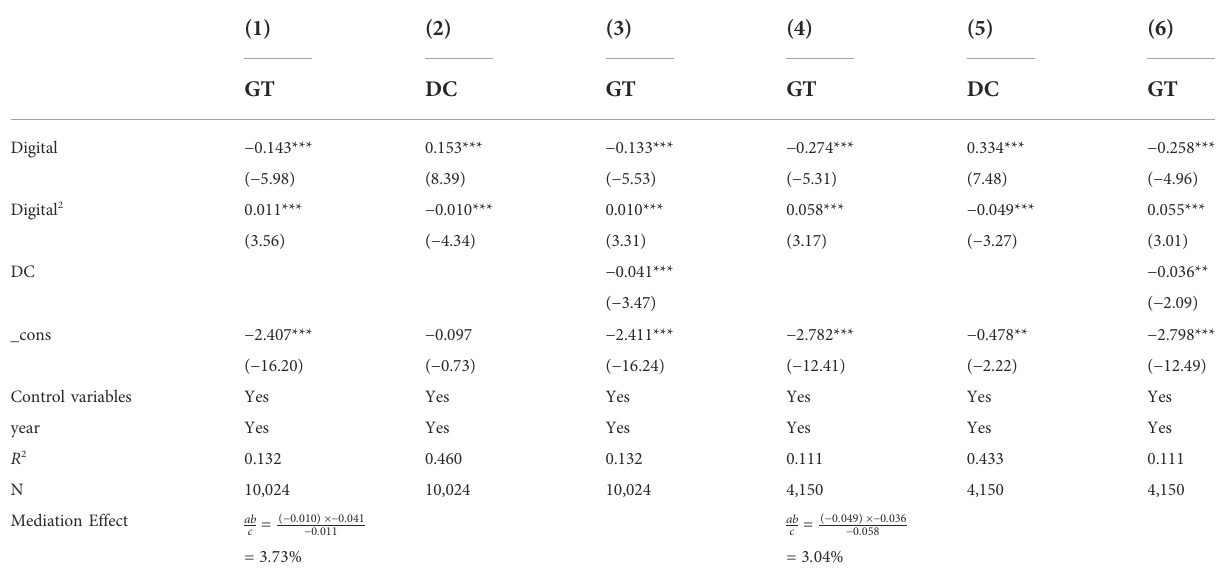
TABLE 9 Mediation effect